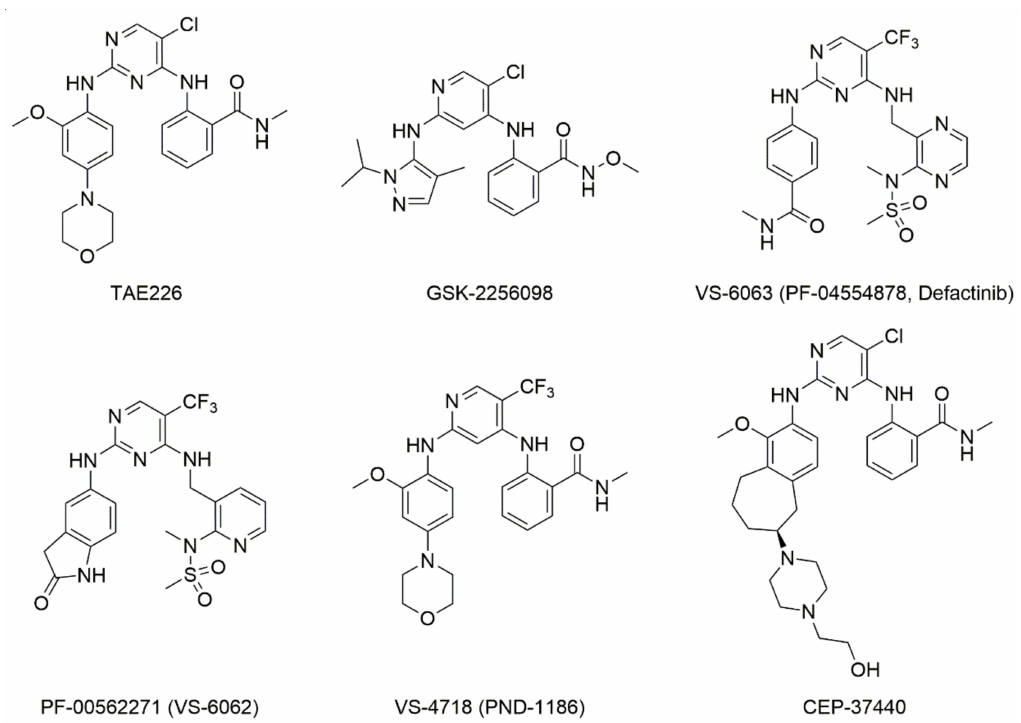
Figure 1. Structures of ATP-competitive FAK inhibitors in preclinical and clinical